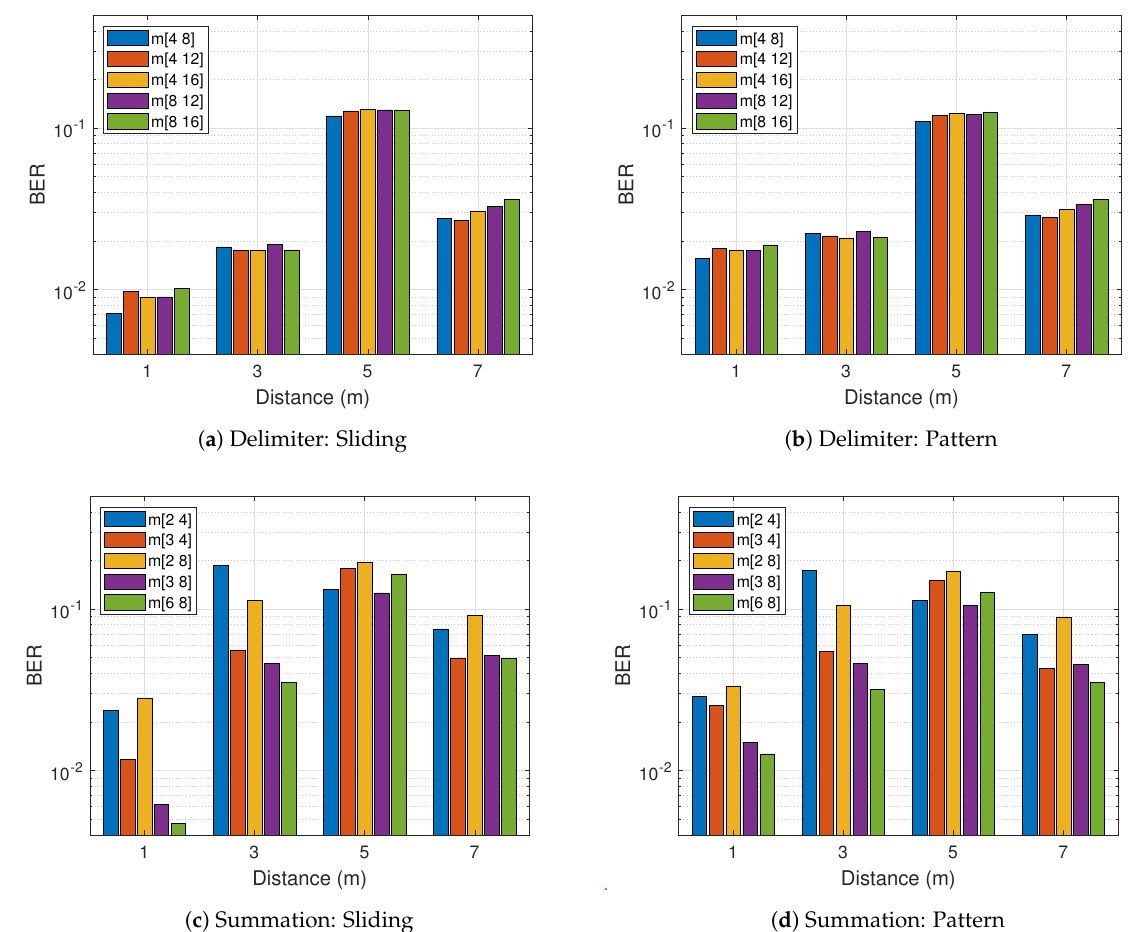
Figure 7. Experimental results for different filter constant m with sliding and pattern-based decoding.